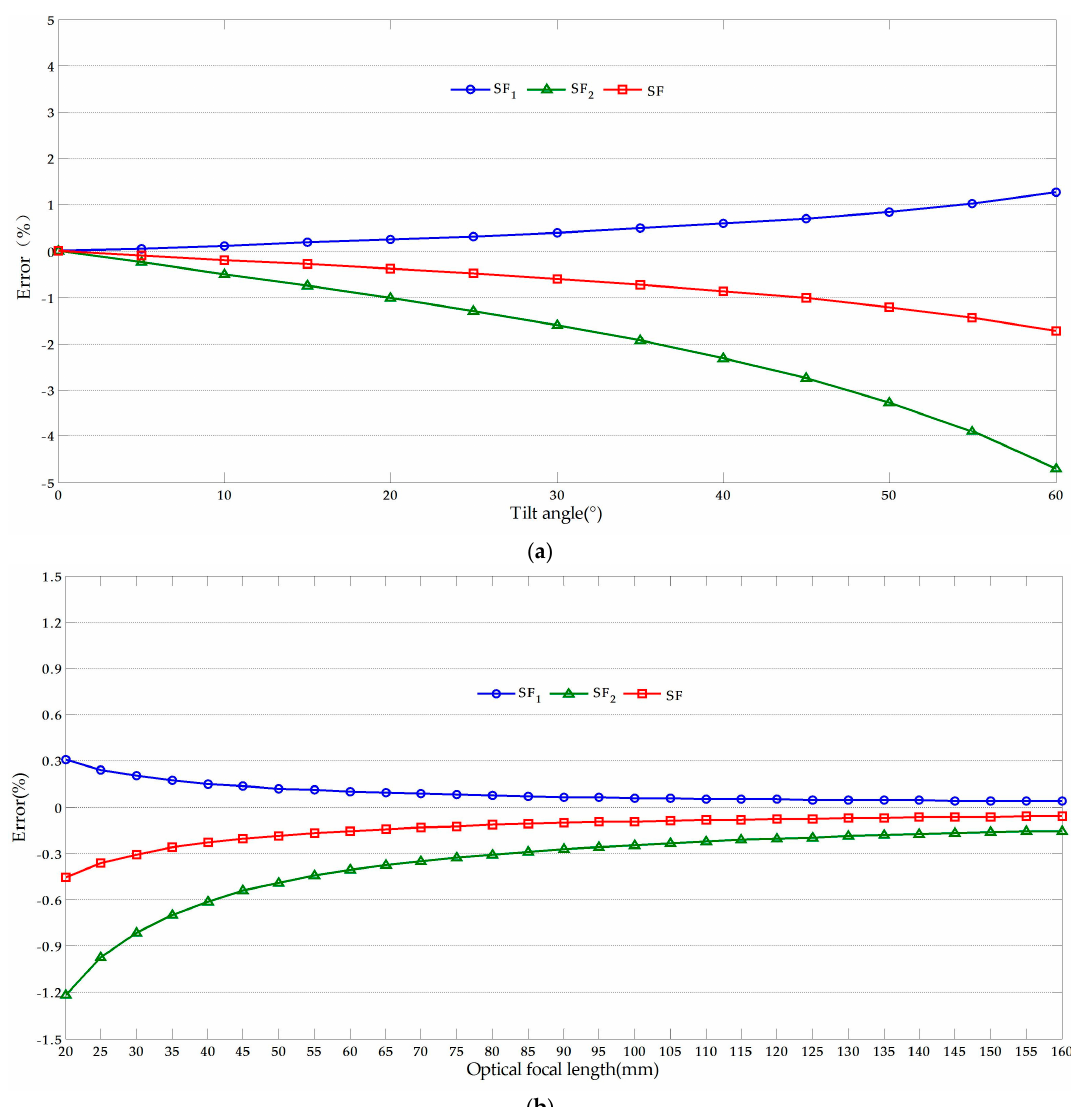
Figure 8. Error analysis results when the measurement point gets closer to the known dimension: ( a ) effects of optical axis tilt angle ( f = 50); ( b ) effects of optical focal length ( θ = 10°).